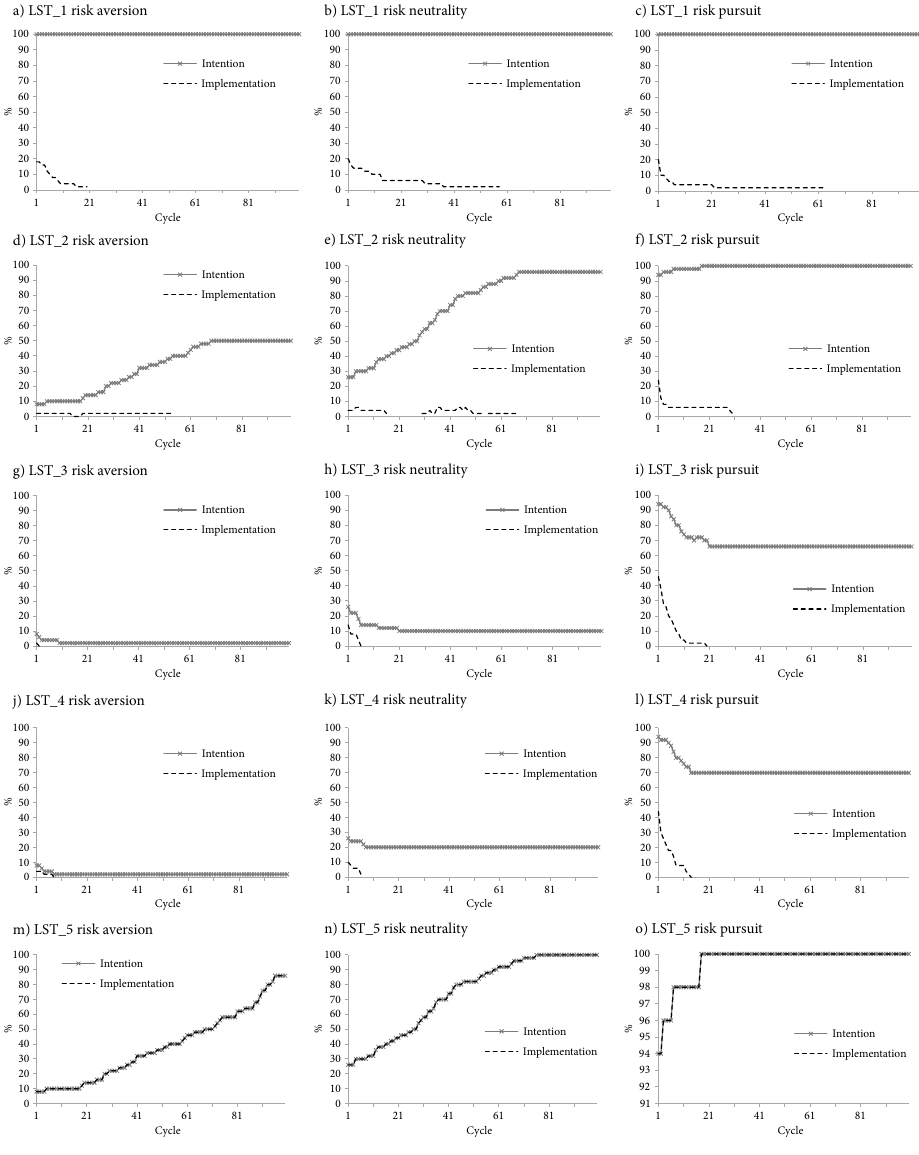
Figure 8. Evolution of entrepreneurs’ innovation behavior in different policy scenarios of low-structured social